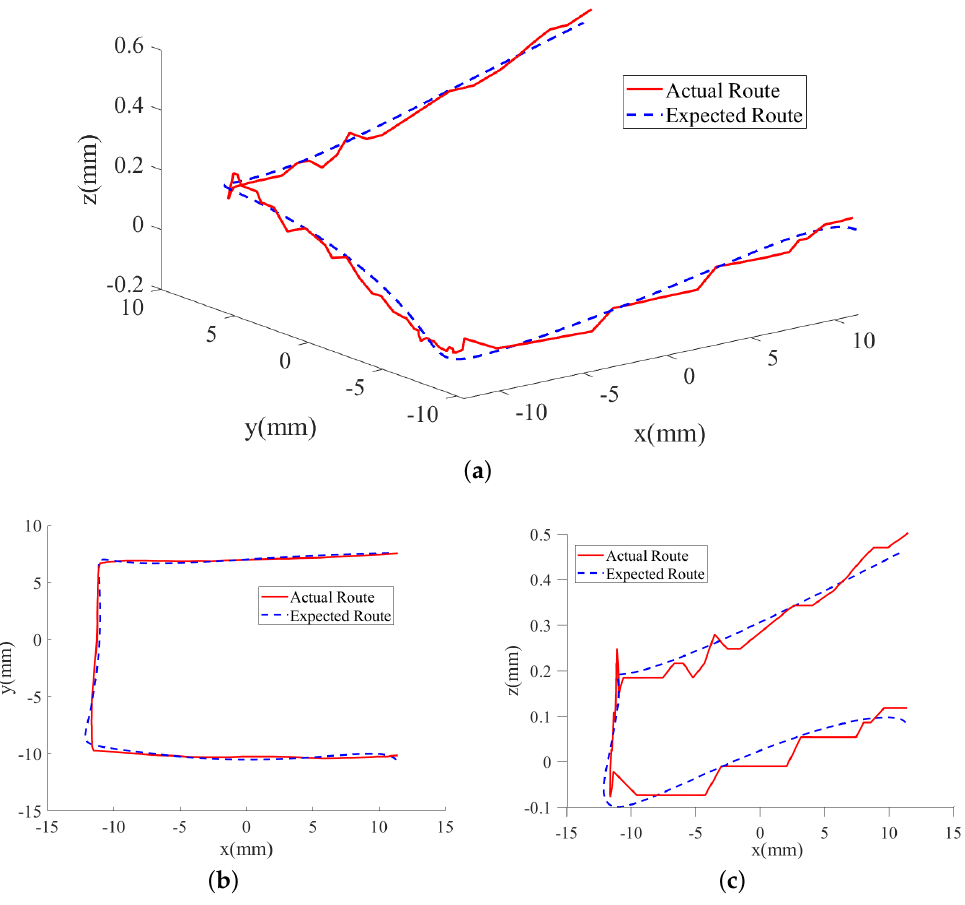
Figure 11. ( a ) Motion trajectory of the controlled magnetic carrier. ( b ) Projection of the trajectory in the XOY plane. ( c ) Projection of the trajectory in the XOZ plane.